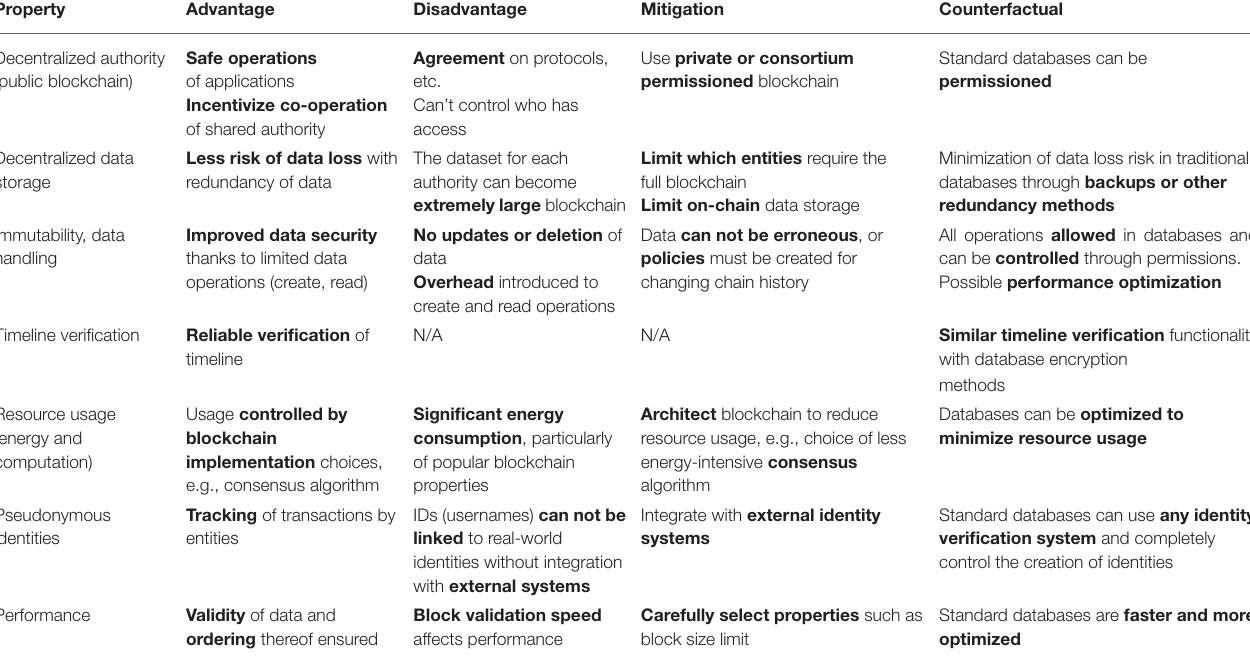
TABLE 2 | Properties of blockchain and how they relate to the EVC use case.